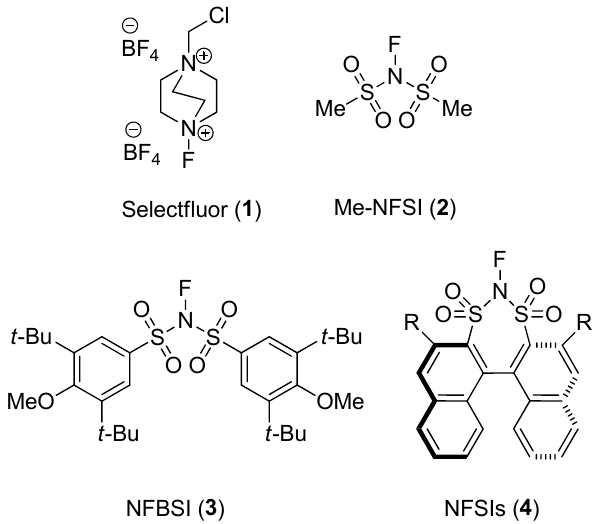
Figure 1. Some commercially available N–F electrophilic fluorination reagents.